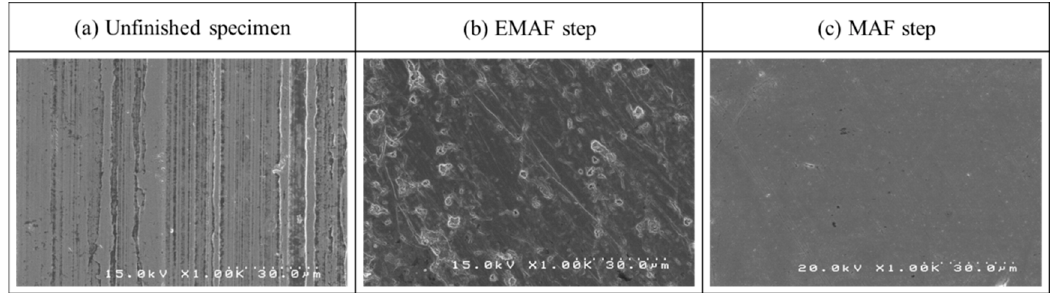
Figure 12. SEM images of the original surface and finished surface after different finishing steps.